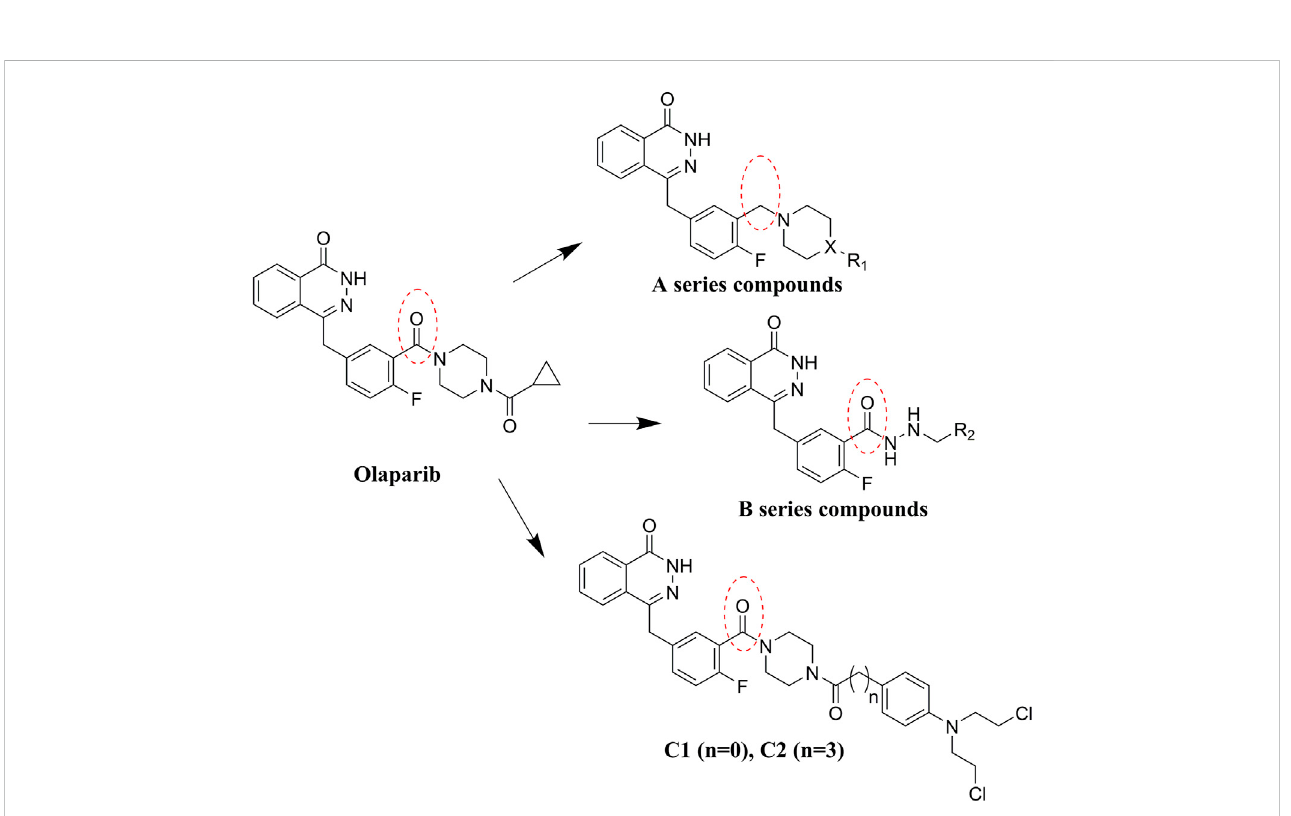
Design of olaparib derivatives in the SAR